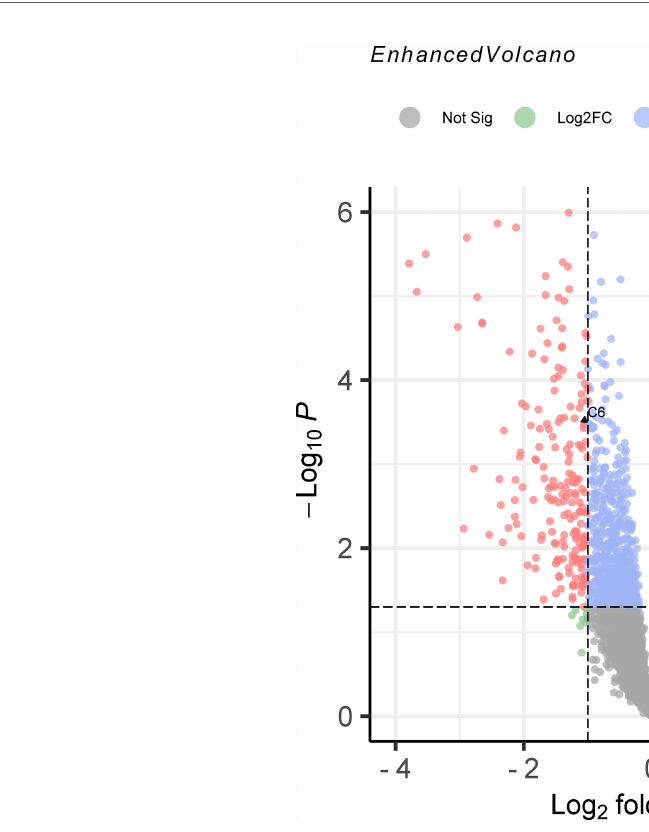
FIGURE 3 | The volcano plot of mRNA expression pro fi les for juvenile idiopathic arthritis (JIA). The results of mRNA expression pro fi les were output to the volcano map. Genes were marked in red point as differentially expressed when the following two conditions were met: P < 0.05 by the moderated t statistic and |logFC| > 1. JIA, juvenile idiopathic arthritis; logFC, log fold change.